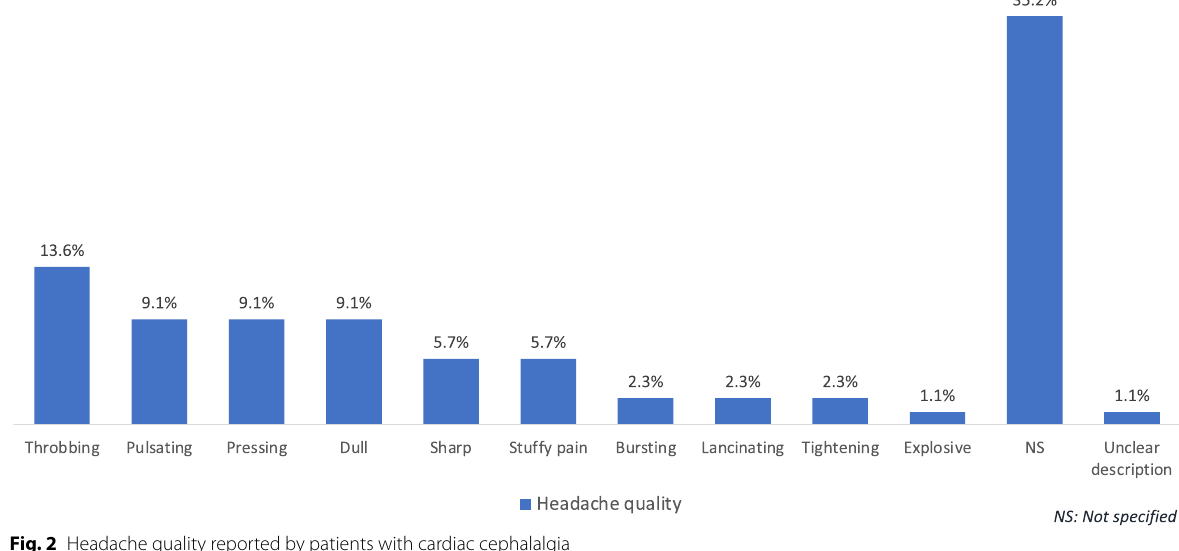
Fig. 2 Headache quality reported by patients with cardiac